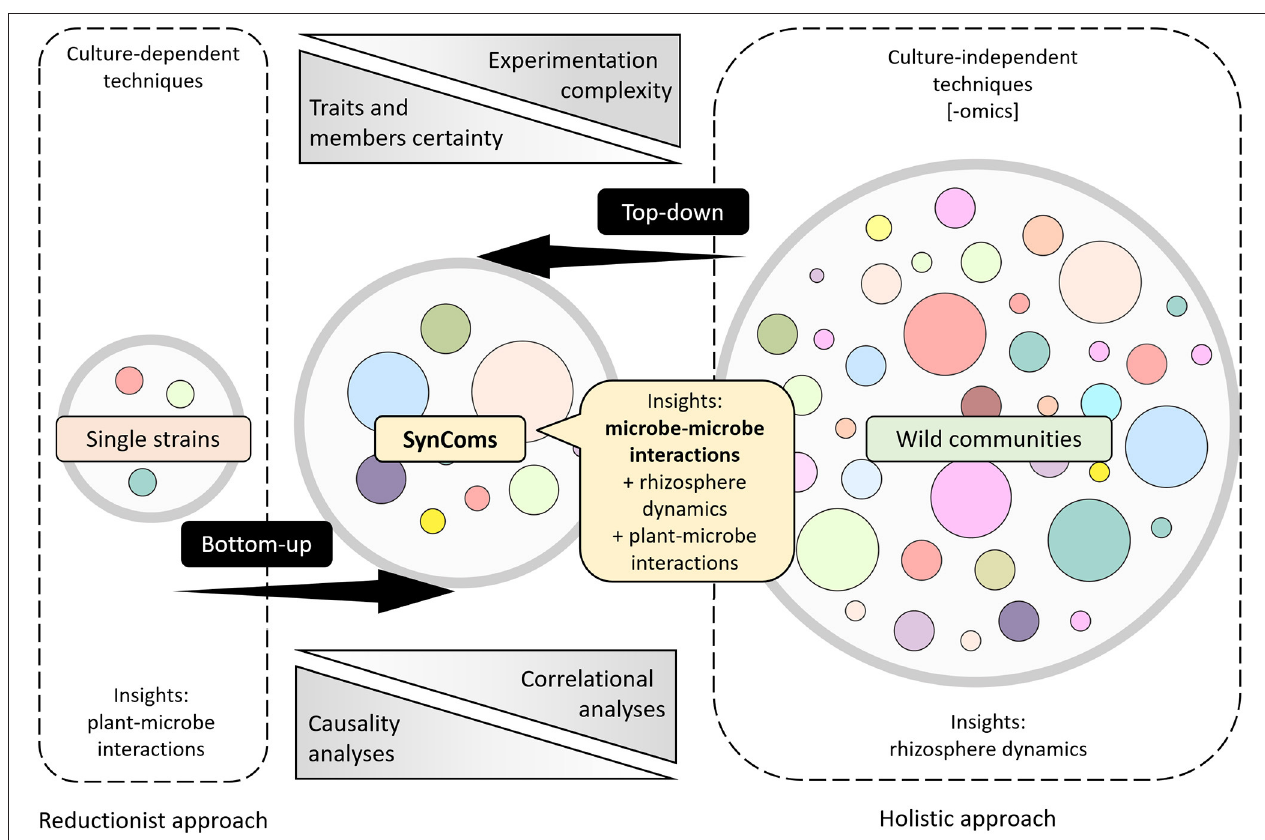
FIGURE 4 | Different approaches to understand the role of the root microbiome in plants. Schematic representation of information processing strategies (top-down and bottom-up) and the approaches that stand on the edges of them (reductionist and holistic). Experimentation complexity increases when more microorganisms are added to the investigation, whereas traits and member certainty decrease. Reductionist approaches tend to rely on causality analyzes, whereas holistic approaches most likely rely on correlational analyzes. SynCom experimentation lies in the middle ground, allowing a better understanding of microbe–microbe